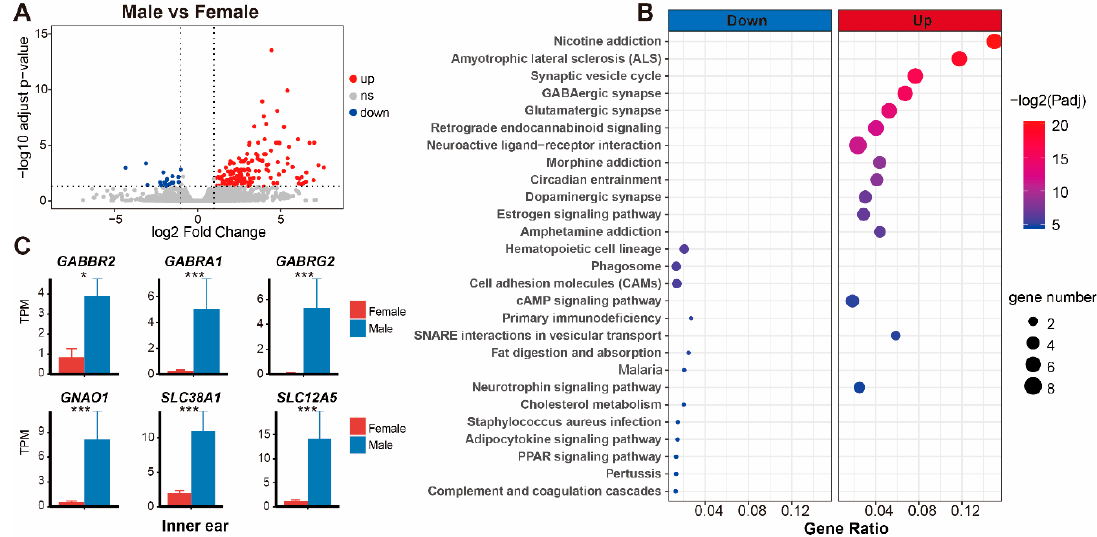
Figure 5. Comparison of transcriptional expression in the inner ear between males and females. ( A ) differentially expressed gene (DEG) screening in the inner ear between sexes. ( B ) KEGG functional items enriched based on DEGs (Padj = q -value). ( C ) Expression of six genes in the GABAergic synapse pathway. ***: q < 0.001, *: q < 0.05.